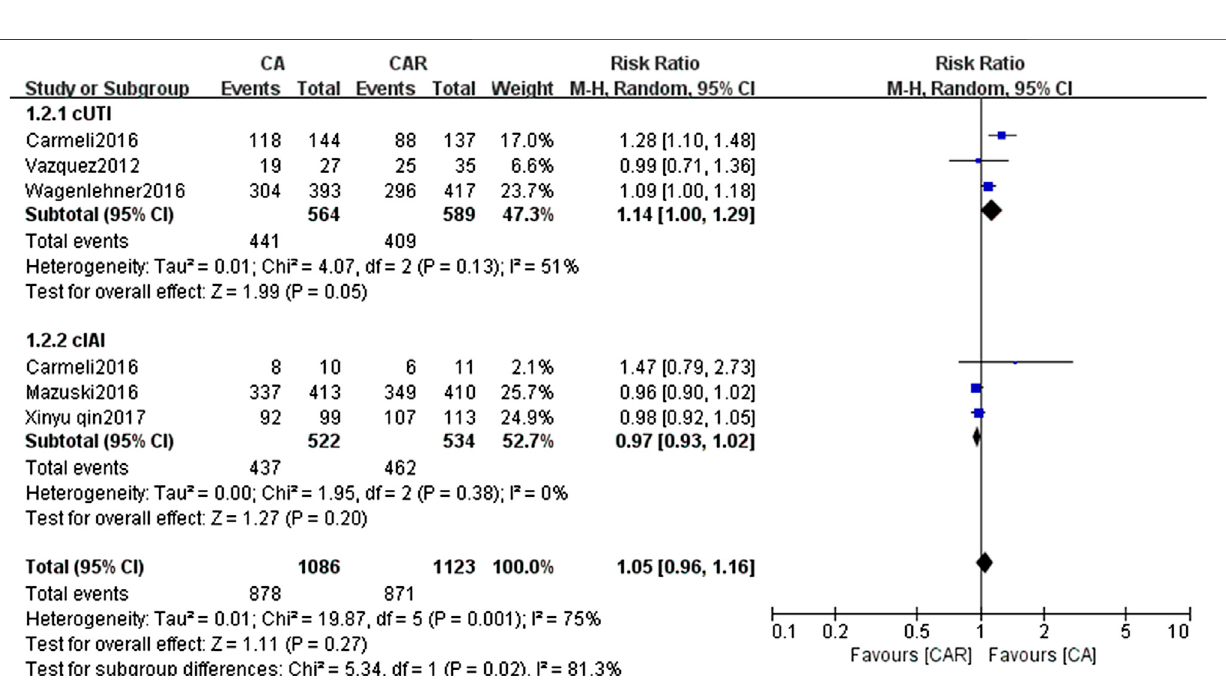
Frontiers in Pharmacology |